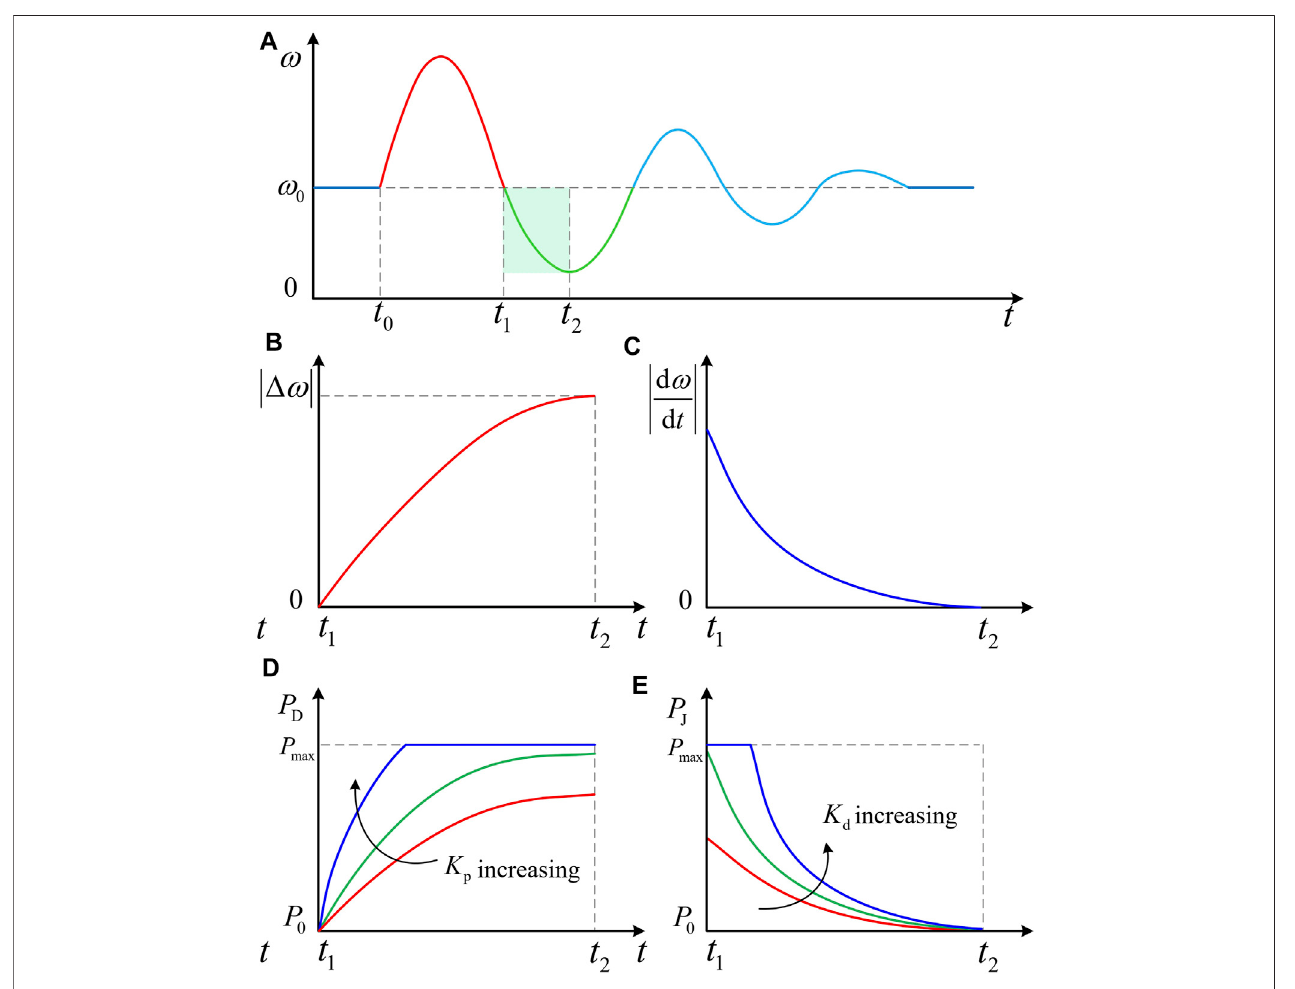
FIGURE 4| Effect of control parameterson inertia control and droop control when frequency falls: (A) rotor speed change ofSG; (B) absolute value ofrotor speed deviation; (C) absolute value of the change rate of rotor speed; (D) the effect of K p on P D ; (E) the effect of K d on P J .